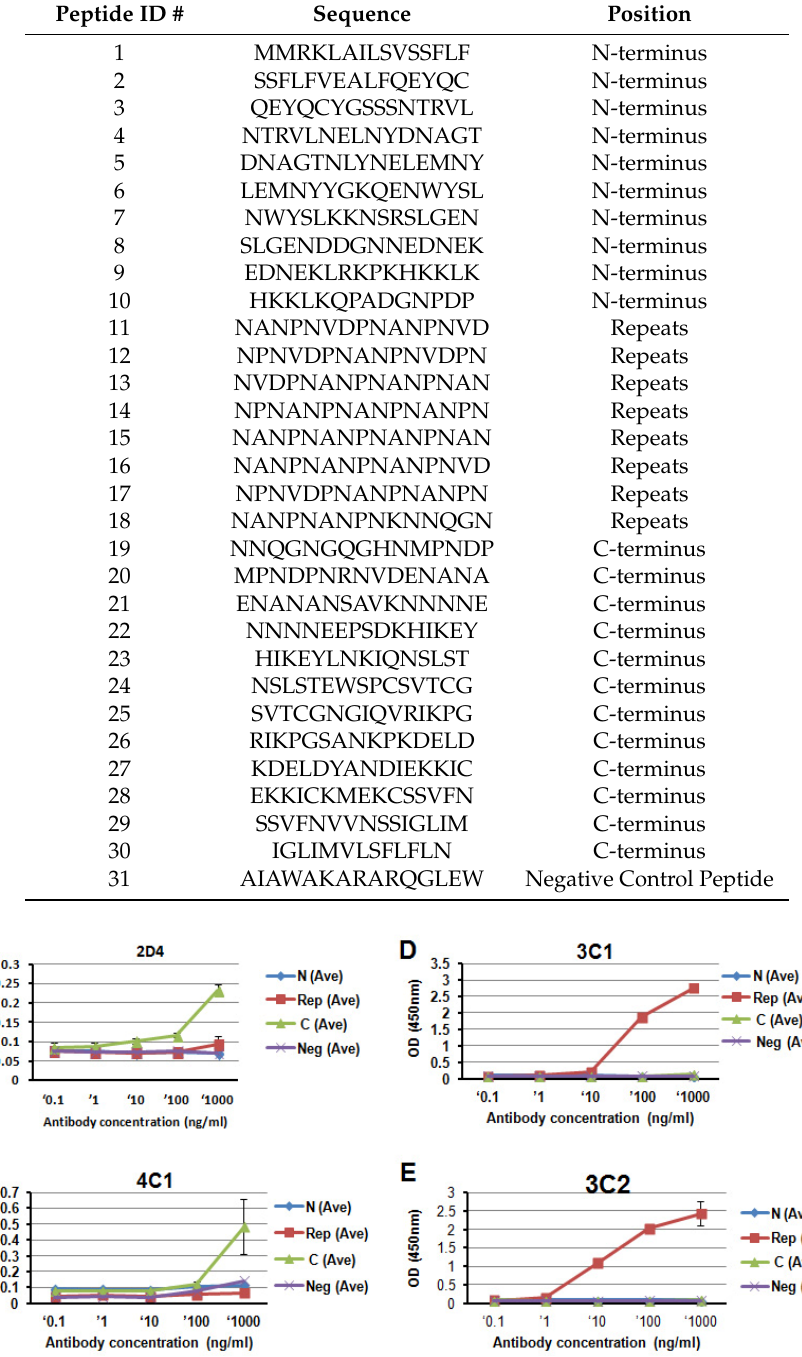
Figure 2. Specificity of anti ‐ PfCSP monoclonal antibodies (mAbs) by enzyme ‐ linked immunosorbent assay (ELISA). Peptides representing PfCSP N ‐ terminal, central repeat, and C ‐ terminal regions were used to evaluate specificity of anti ‐ PfCSP mAbs (Table 1). (A) , 2D4; (B) , 4C1; (C) ,4C6; (D) , 3C1; (E) , 3C2; (F) , 3D3; (G) , 2A10. The mAb 2A10 was used as a positive control. ELISA was performed in duplicate. Data are representative of three independent experiments. OD, Optical density. 3.3. Titration of the PfCSP ‐ Specific mAbs The antibody titer was tested by enzyme ‐ linked immunosorbent assay (ELISA) and immunofluorescence assay (IFA) (Table 1 and Figure 3). ELASA using peptides covering PfCSP showed that the titers of mAbs recognizing the PfCSP central repeat region were higher than those recognizing the PfCSP C ‐ terminal region. The titers of the three mAbs recognizing the PfCSP central repeat were higher than the control 2A10 (3C2 > 3D3 > 3C1 > 2A10). IFA using the Plasmodium sporozoites expressing PfCSP [25] also showed that the titers of the mAbs recognizing the PfCSP central repeat were higher than those recognizing the PfCSP C ‐ terminal region. The titer of the three mAbs recognizing the PfCSP central repeat were higher than the control 2A10 (3C1 > 3D3 = 3C2 > 2A10).